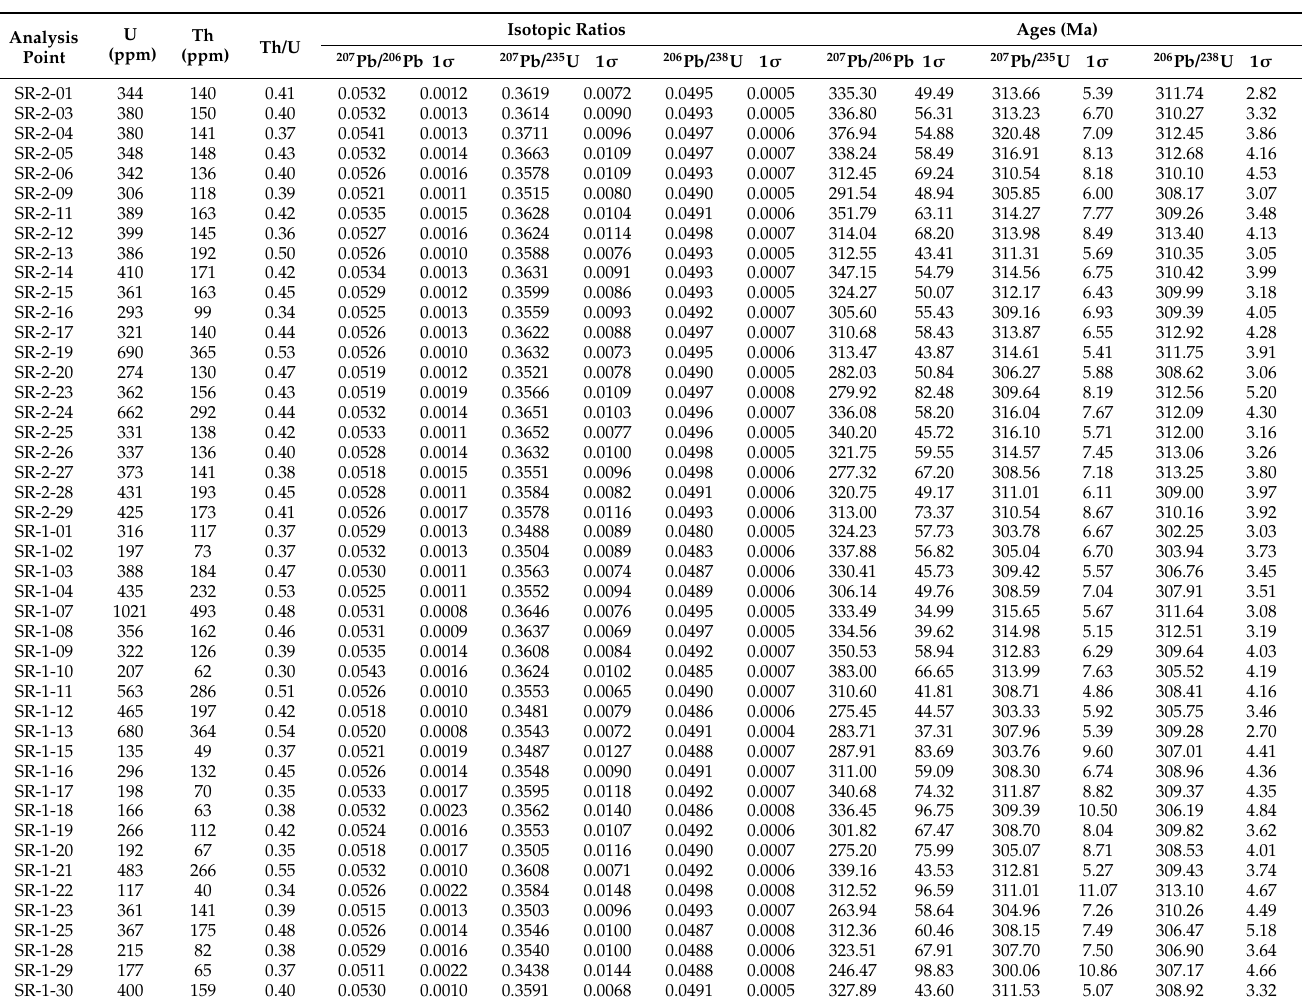
Table 2. Results of the zircon LA-ICP-MS U–Pb dating results for SR2 and SR1 in the Sayashk district.